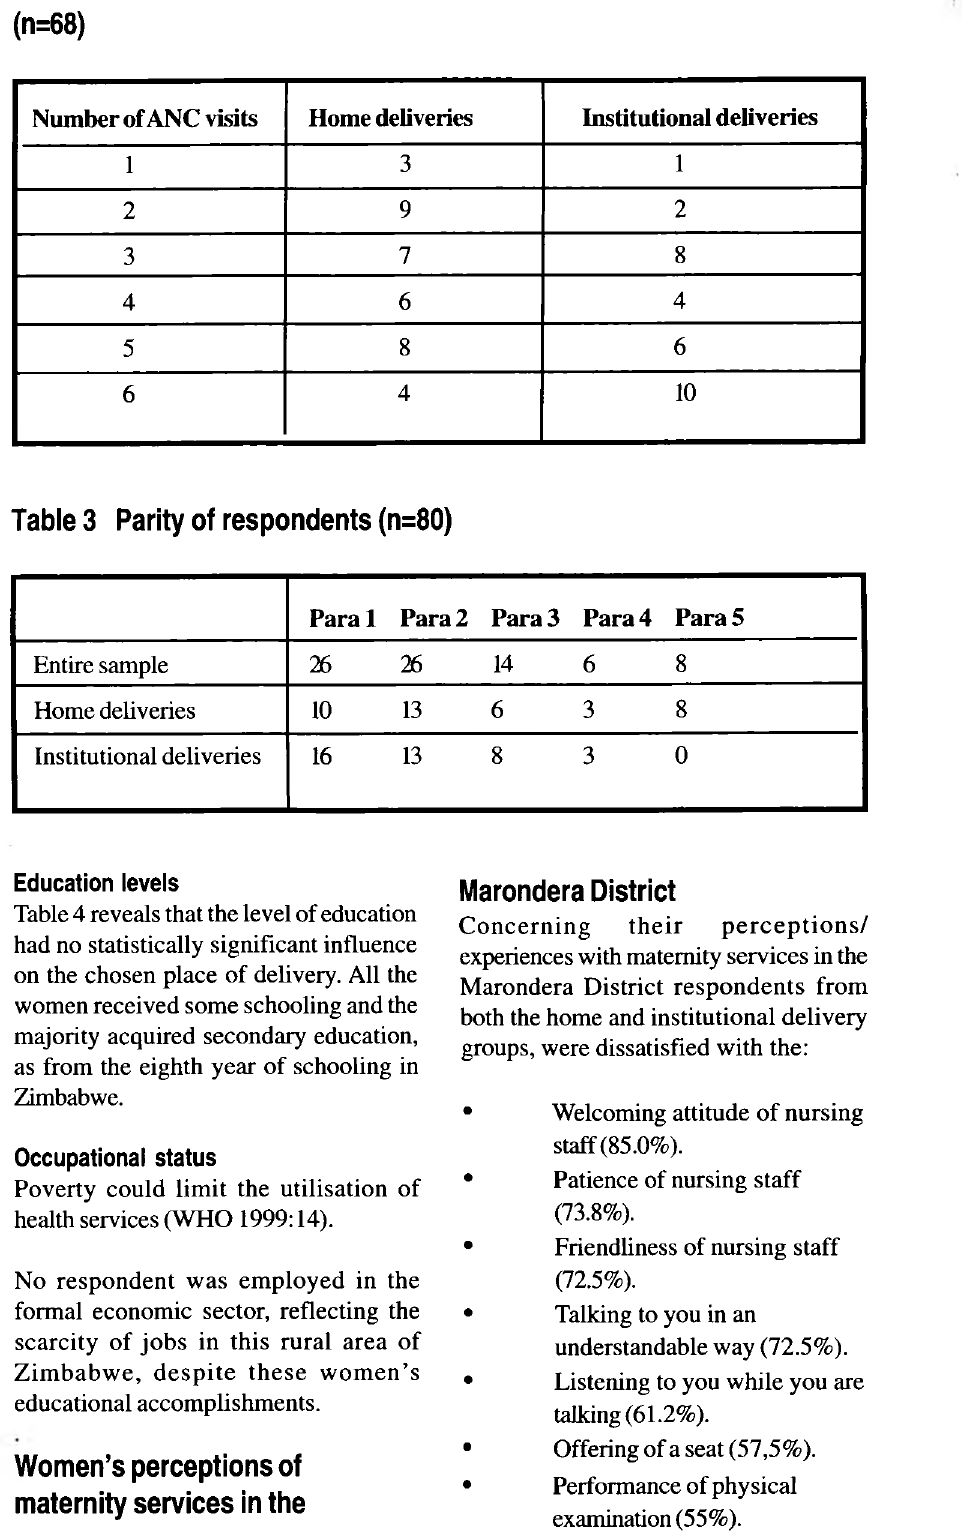
Table 1: Age of respondents: home versus institutional